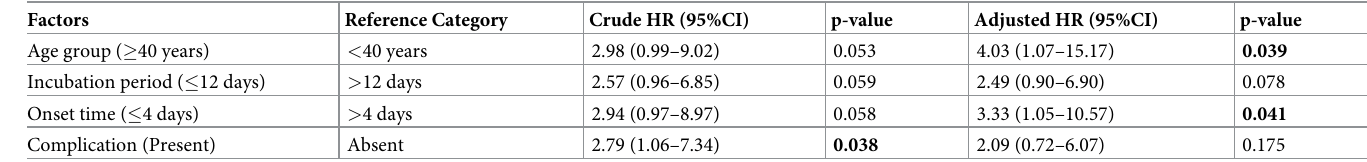
HR: Hazard ratio; Significant p-values are shown in